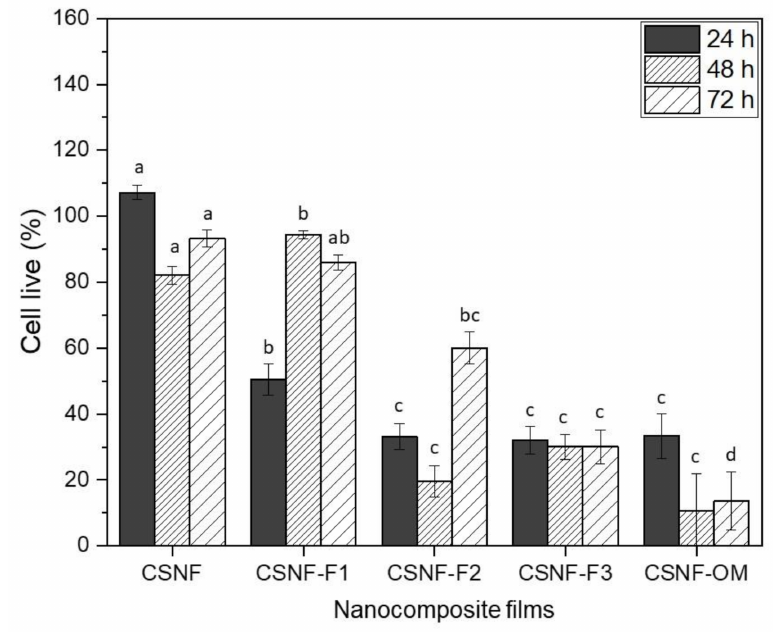
Figure 8. Cell viability of the nanocomposite films. The error bar corresponds to standard deviation (SD, n = 4). Letters in the bars with the same color denote significant differences among the different films and the same cell culture time (Duncan’s test, p <